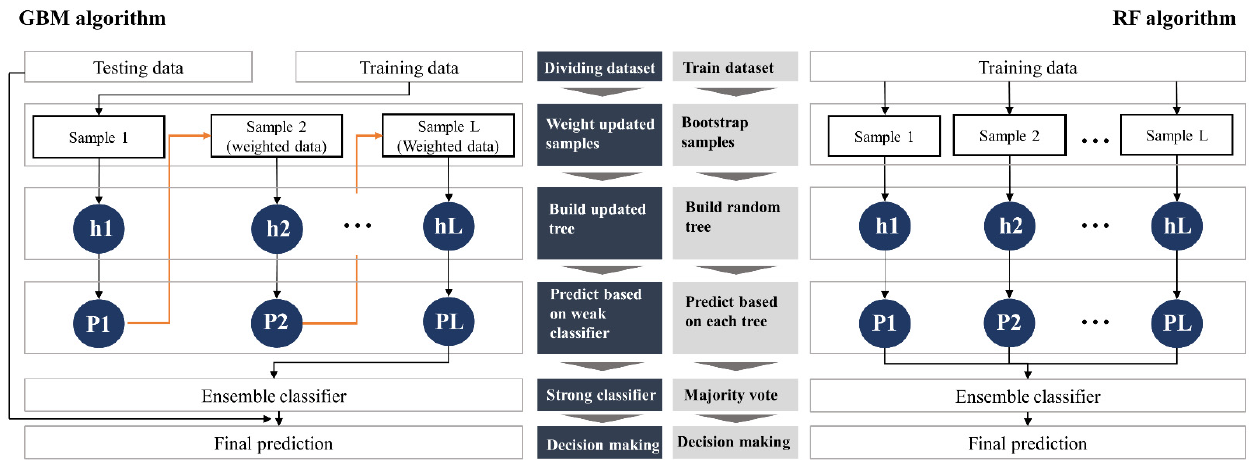
Figure 2. Comparison of the structure and workflows of the gradient boosting machine (GBM) and random forest (RF) algorithms.